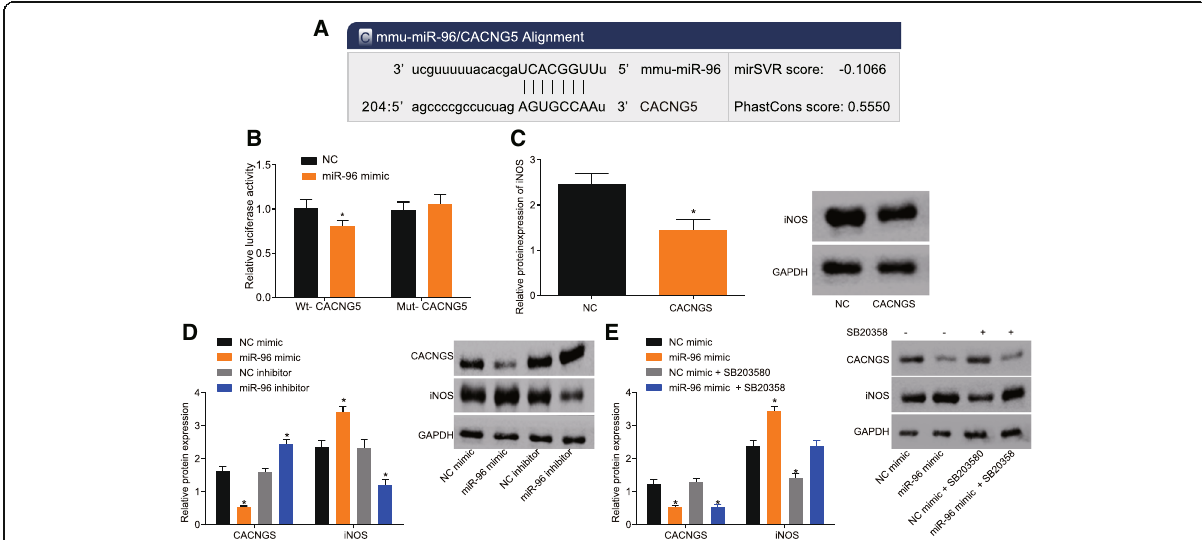
Fig. 2 miR-96 is predicted to regulate the MAPK signaling pathway via CACNG5. a prediction of target relationship between miR-96 and CACNG5 promoter region; b the effect of miR-96 on WT-CACNG5 and Mut-CACNG5 luciferase reporter plasmid; c the effect of CACNG5 on the expression of iNOS protein; d and e , effect of miR-96 on the expression of iNOS protein. * , P < 0.05 compared with the NC group. The test was repeated three times independently, and the non-paired t-test was used for comparison between the two groups; the one-way ANOVA analysis was used for comparison among multiple groups. miR-96, microRNA-96; CACNG5, calcium voltage-gated channel auxiliary subunit gamma 5; Wt, wild-type; Mut, mutant; NC, negative control